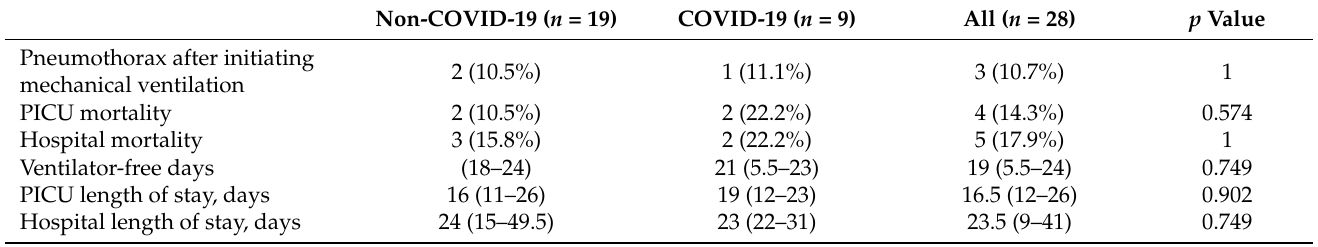
Table 4. Outcome measures. Categorical variables are expressed as numbers (%), and continuous variables are expressed as median (P 25 –P 75 interquartile range). PICU, Pediatric intensive care unit.